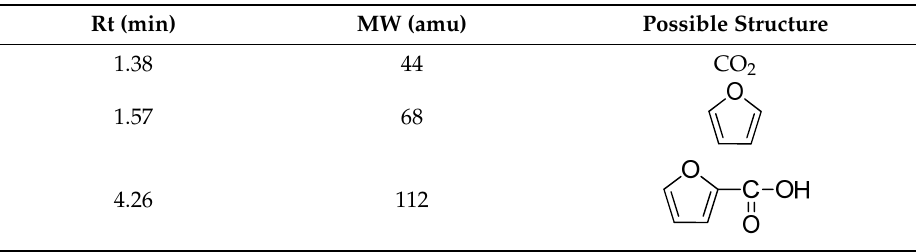
Table 4. Identified pyrolysis products of PIsF.